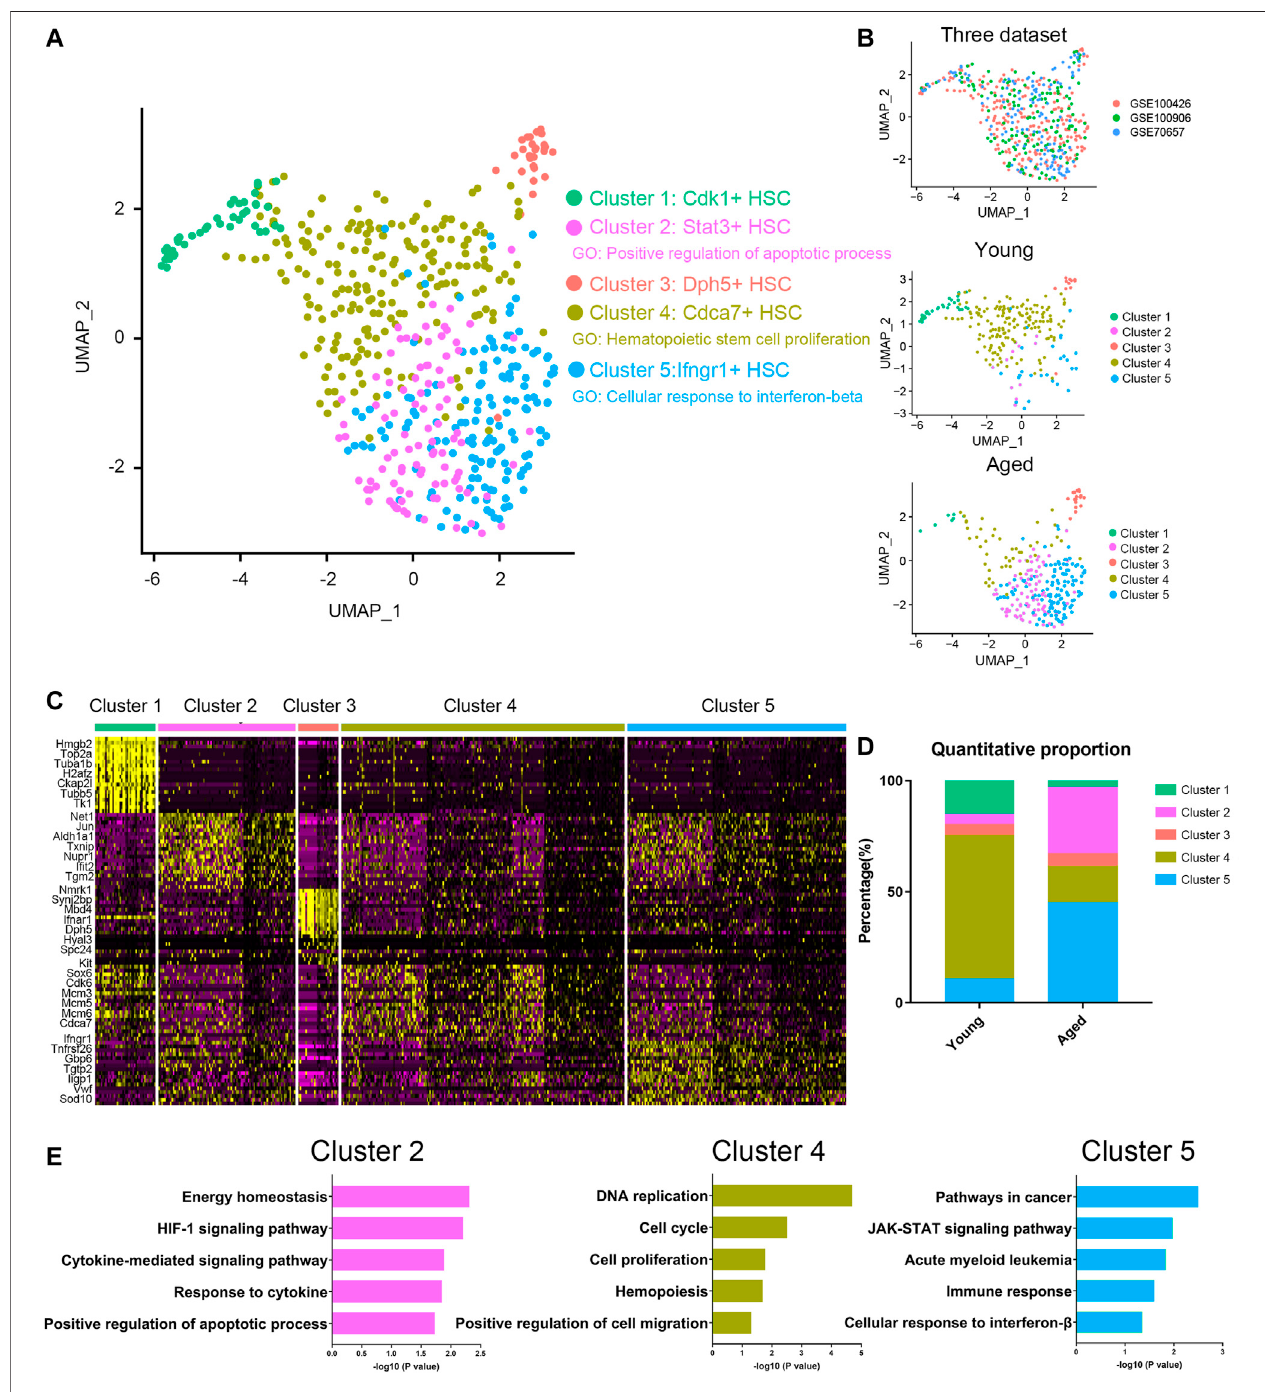
FIGURE 1 | Cellular heterogeneity within young and aged HSCs. (A,B) UMAP plot of HSCs analyzed. Five different clusters and cells from three datasets were labeled by color. (C) Heatmap of the most signi fi cant DEGs in the different clusters. (D) Quantitative proportions of different clusters in young and aged HSCs. (E) Functional enrichment (biological process and KEGG pathways enrichment) of DEGs of Cluster 2, Cluster 4 and Cluster 5.